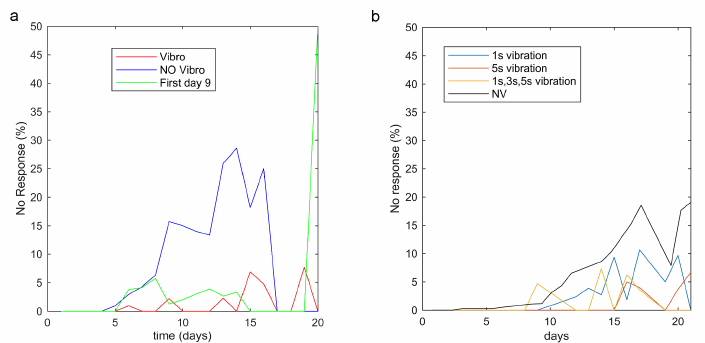
Figure 7. No movement detection. ( a ) In experiment 2 (habituation experiment), few animals were left in the three samples on the last days (2–4), due to nematode death. At such low survival rates, the non-response ratios were variable as of day 18. On day 20 of “first 9 days of the stimulation conditions” (green curve), the non-response ratio was 50% because there were only two worms left. ( b ) Experiment 1, the blue condition shows the no-response percentage after applying a 1 s vibration, the red condition applied a 5 s vibration, the orange one lasted 1 s [on days 9, 12, 13 and 14], 3 s [days 15, 16, 17 and 19] and 5 s [days 20 and 21], while the grey one denotes the no-vibration